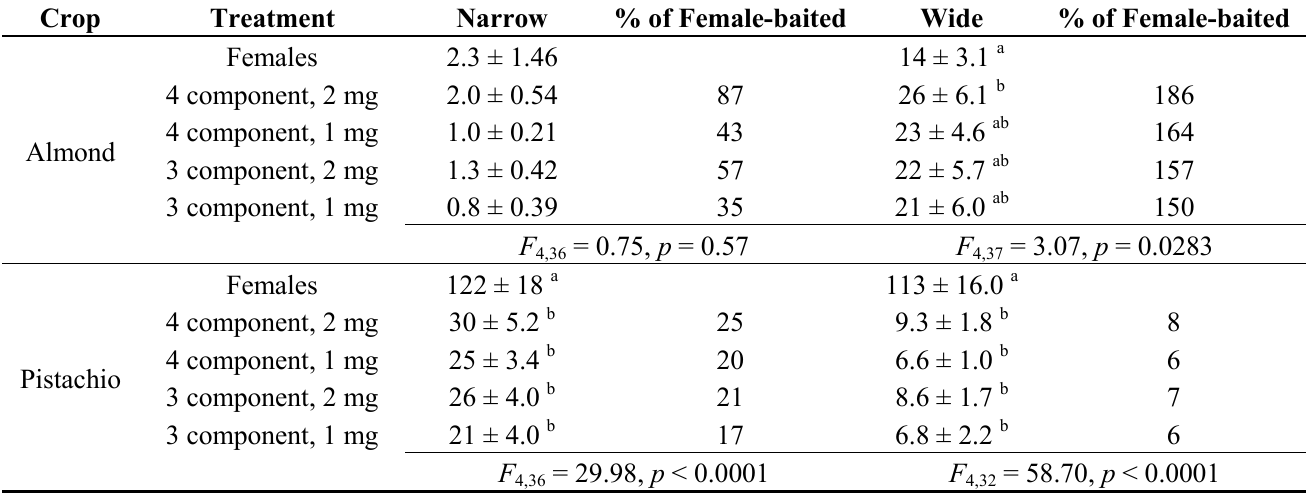
Table 3. Males per trap (mean ± SE) over the first 42 days of experiments with traps spaced either narrowly (37 m) or widely (60